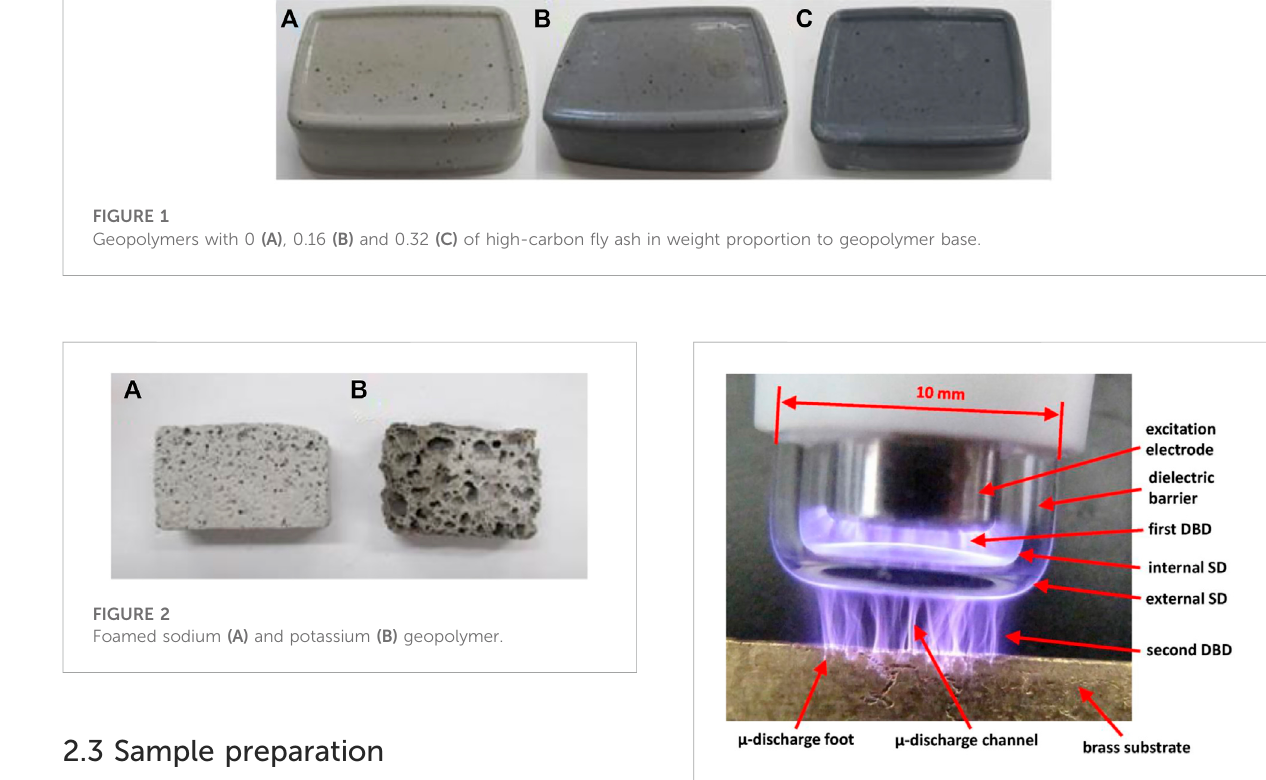
FIGURE 3 Example of Piezobrush PZ2 Near- fi eld nozzle used